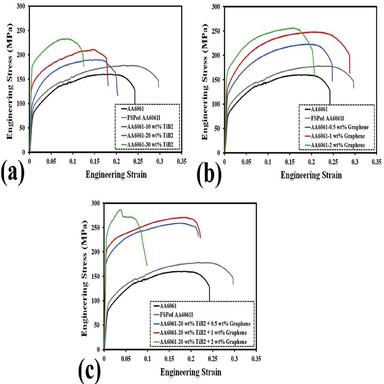
Tensile flow behaviors for the (a) AA6061-TiB2 single composites, (b) AA6061-Graphene single nanocomposites, and (c) AA6061-Graphene-TiB2 hybrid nanocomposites, as compared to the annealed and FSP modified AA6061 aluminum alloys during longitudinal tensile testing.